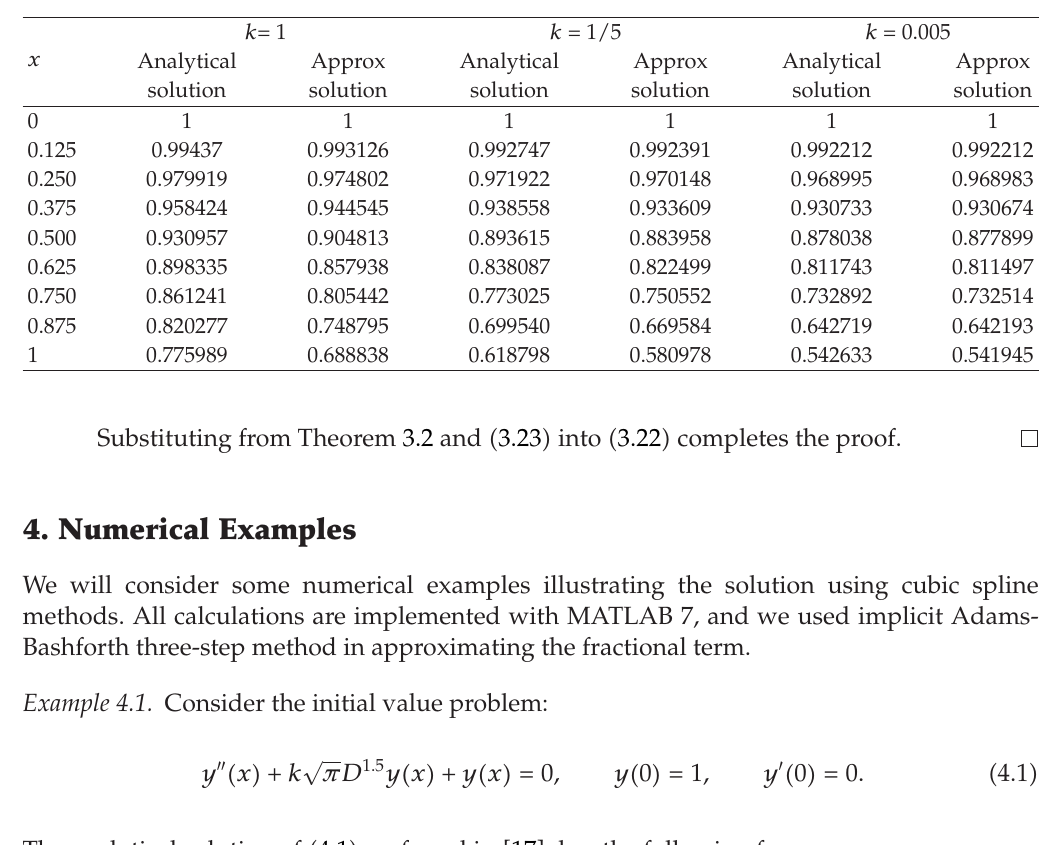
Table 1: Numerical results of Example